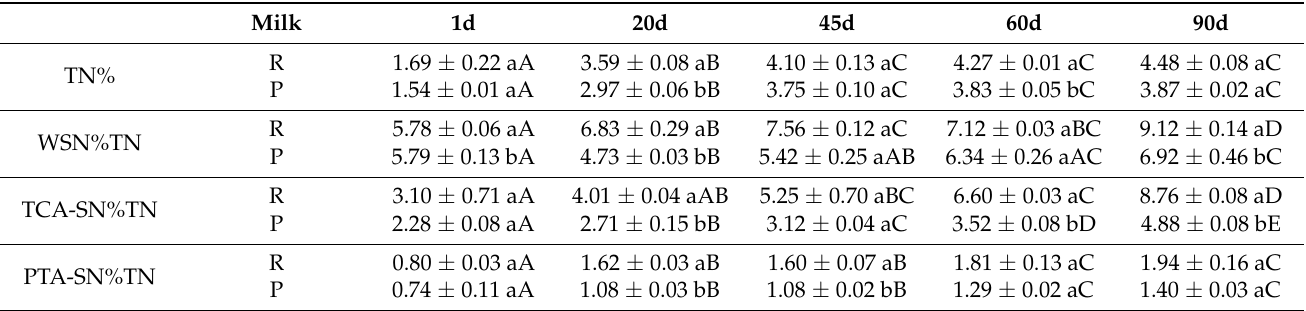
Table 3. Changes in nitrogenous fractions of hard Xinotyri cheese made from raw (R) or pasteurized (P) milk, during ripening and storage (i)